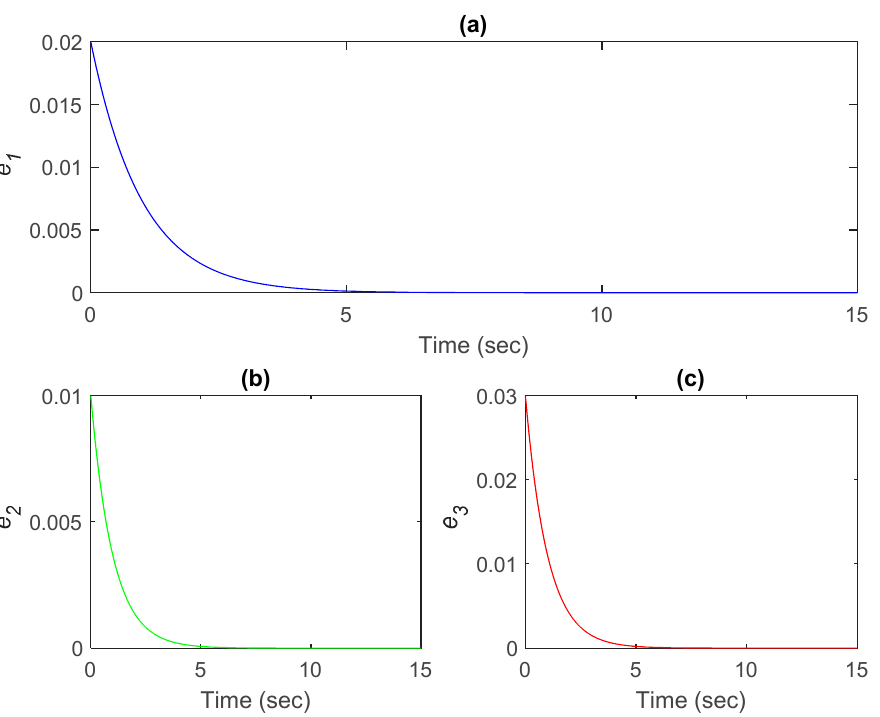
Figure 12. Bifurcation diagram of controlled system under 𝜌 + 𝜌𝜀 sin𝜔𝑡 , 𝛿 + 𝛿𝜀 sin𝜔𝑡 , and 𝜂 + 𝜂𝜀 sin𝜔𝑡 . 6. Conclusions Based on our analysis of nonlinear dynamics, we recommend an effective means to controlling chaos in BLDCM. The bifurcation diagram reveals that a BLDCM exhibits period-doubling bifurcation, period-three bifurcation, and chaotic motion. A period- doubling cascade is an infinite sequence of period-doubling bifurcations. Such cascades